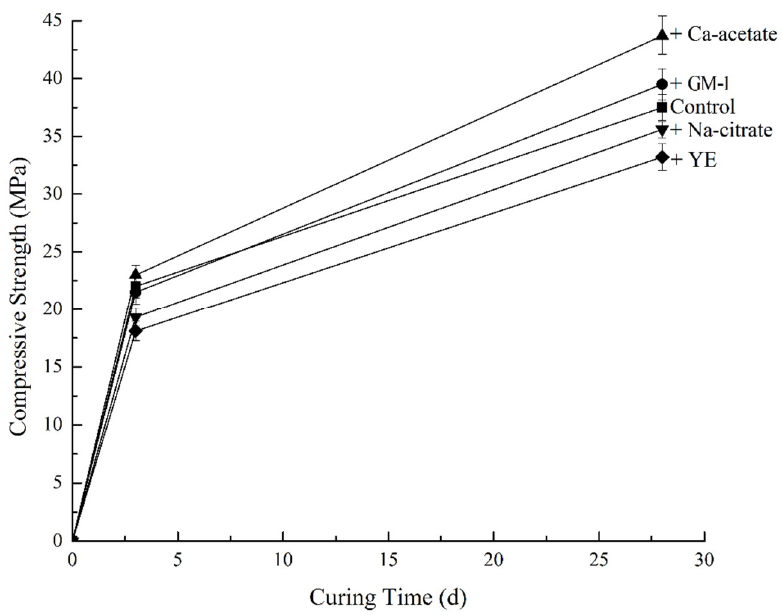
Figure 4. Compressive strength development of mortars.